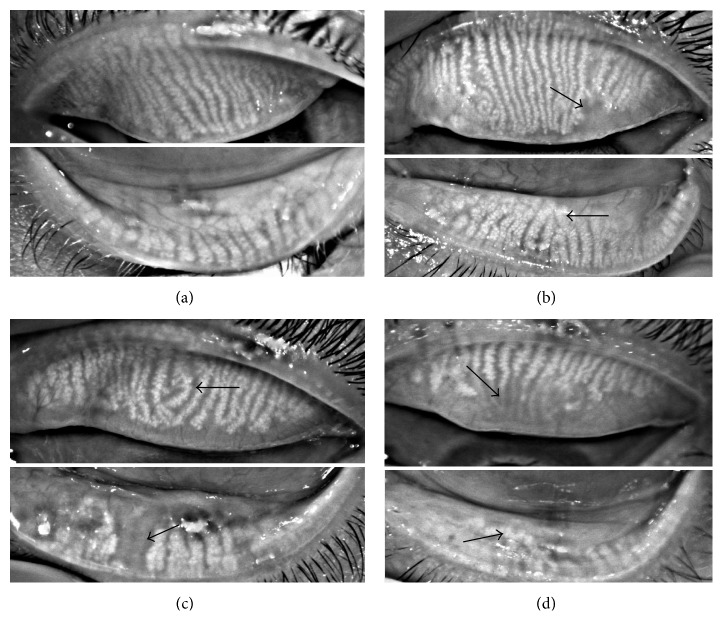
Noninvasive meibographic images of the upper and lower eyelids, respectively. (a) No morphologic changes of meibomian glands in either eyelid were apparent (meiboscore of 0). (b) Minor morphologic changes of meibomian glands in both upper and lower eyelids were apparent (meiboscore of 1). The arrow in the upper eyelid shows the partial absence of meibomian glands, and the arrow in the lower eyelid shows a minor distortion of meibomian glands. (c) Less than 1/3 of the meibomian gland loss and minor morphologic changes in both upper and lower eyelids were apparent (meiboscore of 2). The arrow in the upper eyelid shows partial distortion of meibomian glands, and the arrow in the lower eyelid shows an obvious meibomian gland loss. (d) More than 2/3 of shortening, distortion, and dilation of meibomian glands were observed in both eyelids (meiboscore of 5). The arrow in the upper eyelid shows a large area of meibomian gland loss, and the arrow in the lower eyelid shows a significant distortion and dilatation of meibomian glands.